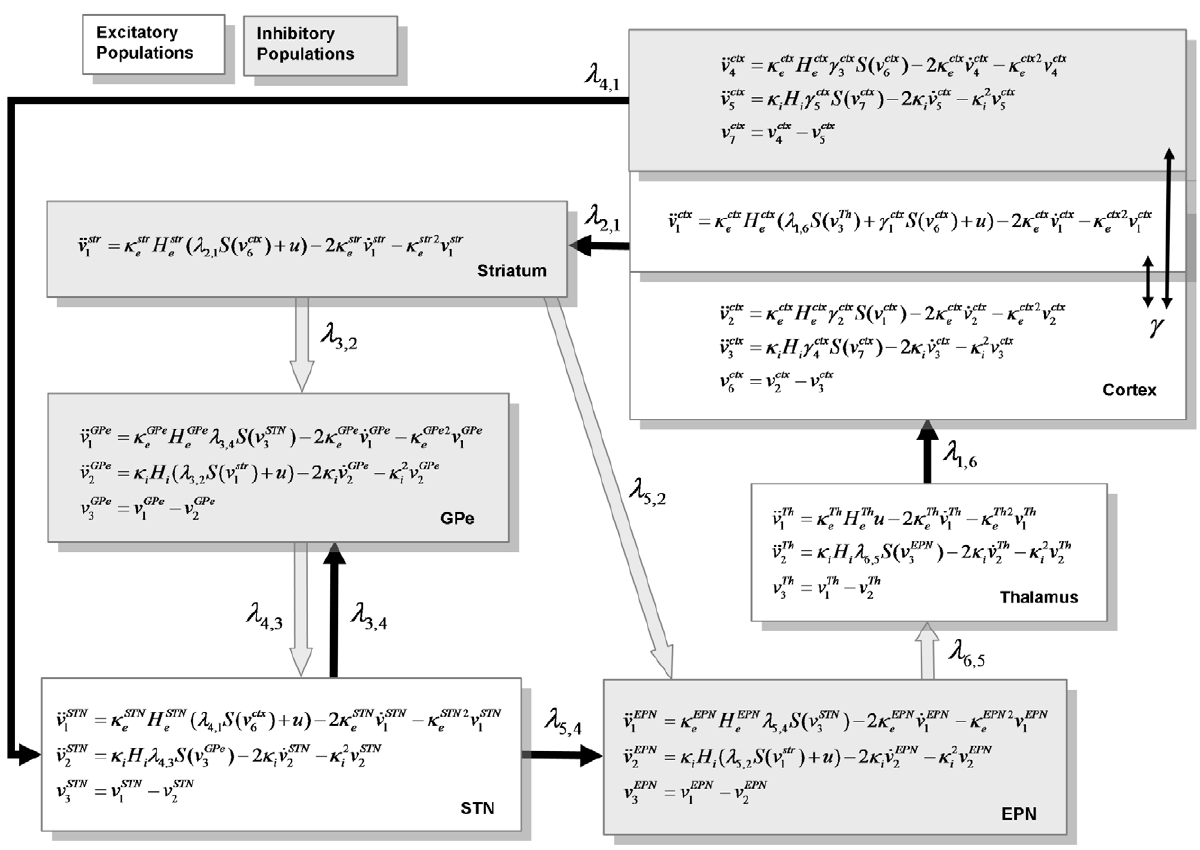
Figure 3. Neural mass model of cortico-basal ganglia-thalamocortical circuit. These are the differential equations modelling the hidden neuronal states in the subpopulations comprising the nodes of the circuit model. These equations take the form of Equation 7. For simplicity, we describe the have dropped the dependency on time and have therefore omitted the delays (see Equation 7). In the cortex, the parameters c ctx , c ctx 5 3 intrinsic connections from the pyramidal cells within the same cortical source and reciprocal inhibitory afferents respectively and v ctx ( t ) represents 7 the average membrane potential of inhibitory cells. In the granular layer, spiny stellate cells receive excitatory connections from the thalamus, with . In turn, pyramidal cells in the cortex receive inhibitory inputs strength l 1,6 and excitatory inputs from pyramidal cells within the same region c ctx 1 from the interneurons within that cortical region and excitatory inputs from the stellate cells within that region mediated by intrinsic connectivity and c ctx respectively. The pyramidal cells from the cortex send efferent extrinsic connections to the basal-ganglia, arriving at the parameters c ctx 2 4 striatum with a strength parameterised by l 2,1 and to STN, with strength l 4,1 . At the striatum, one inhibitory subpopulation models GABAergic projection neurons with input from cortex. These striatal GABAergic projection neurons then inhibit both GPe and EPN, such that the dynamics in the GPe are modelled as an inhibitory network with input u ( t ) and connections from the STN with effective connectivity l 3,4 . This population is inhibited by the striatum with an effective connectivity of l 3,2 . The STN is reciprocally connected to GPe, receiving inhibitory connections mediated by l 4,3 and is excited by the cortex via the hyperdirect pathway with effective connectivity l 4,1 . The EPN receives inputs from both STN (glutamatergic) l 5,4 and the striatum (GABAergic) l 5,2 and sends feedforward inhibition to the thalamus l 6,5 . Excitatory connections from thalamus to cortex complete the closed loop